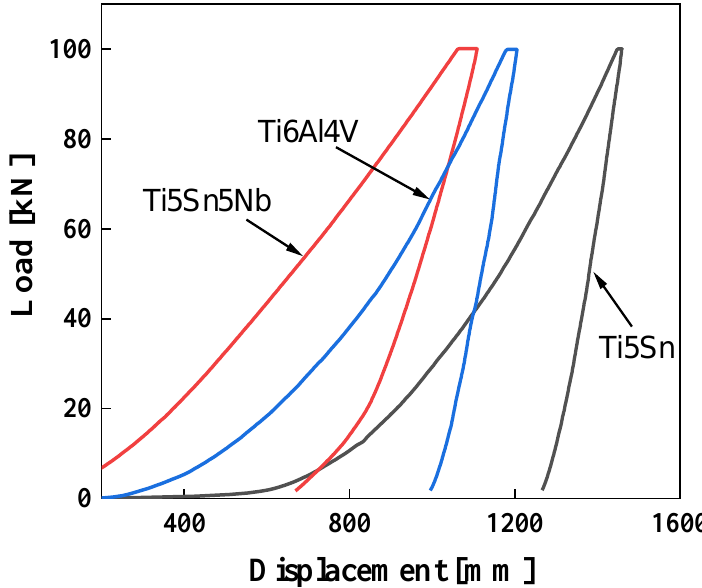
Figure 7. Nano hardness curves of Ti6Al4V, Ti5Sn, and Ti5Sn5Nb. Red line indicates Ti5Sn5Nb alloy. Blue line represents Ti6Al4V alloy, and black line shows Ti5Sn alloy. Nano Hardness